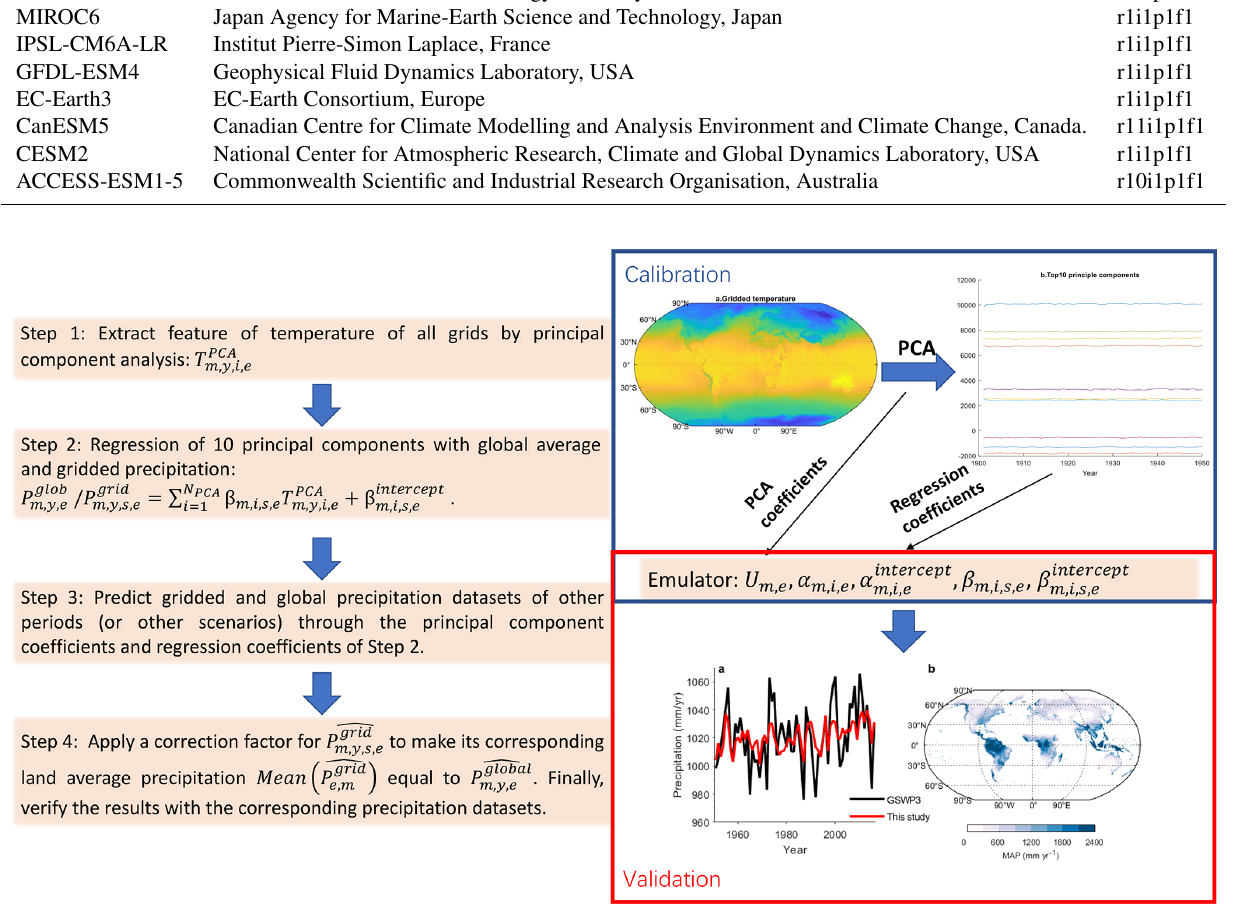
Figure 1. Illustration of the precipitation emulator driven by the gridded temperature. Step 1 is to extract the features of gridded temper- ature through principal-component analysis. In Step 2, we construct the parameters of the emulator by regression of GLAP or gridded precipitation and the principal components of gridded temperature. Then we use the emulator to predict the precipitation for the validation period or scenario in Step 3. Finally, we calibrate the precipitation and verify the results with precipitation from GSWP3 and ESMs. Here, T PCA e,m (y,i) is the principal components extracted by PCA. P global e,m (y) is the GLAP, and P grid e,m (k,y) is the precipitation of a given grid k . α e,m (i)/β e,m (k,i) represents the coefficients of each principal component of temperature in relation to global and/or gridded precipitation, and α intercept e,m (i)/β intercept e,m (k,i) is the intercept term. U Spatial e,m (k,i) is the PCA coefficients. Note that the gridded temperature from GSWP3 has an area-weighted average of 2.5 ◦ × 2.5 ◦ before